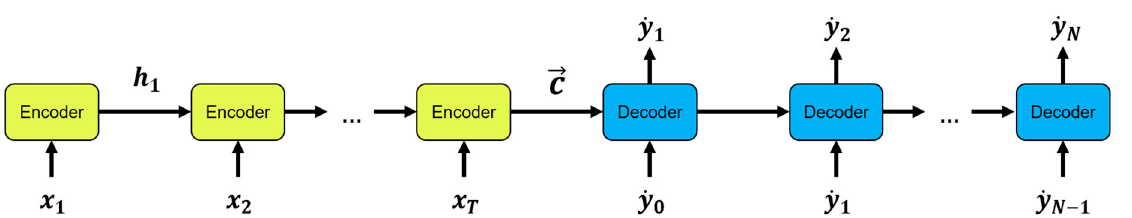
Figure 7. Sequence-to-Sequence recurrent neural network.